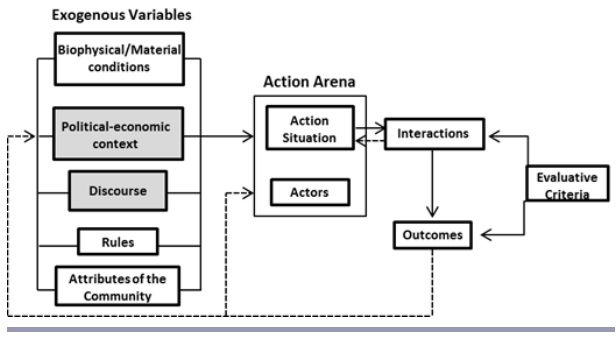
Fig. 2 . The politicized institutional analysis and development framework, with the two variables that have been analyzed in separate studies shaded in gray. Adapted from Clement (2010).